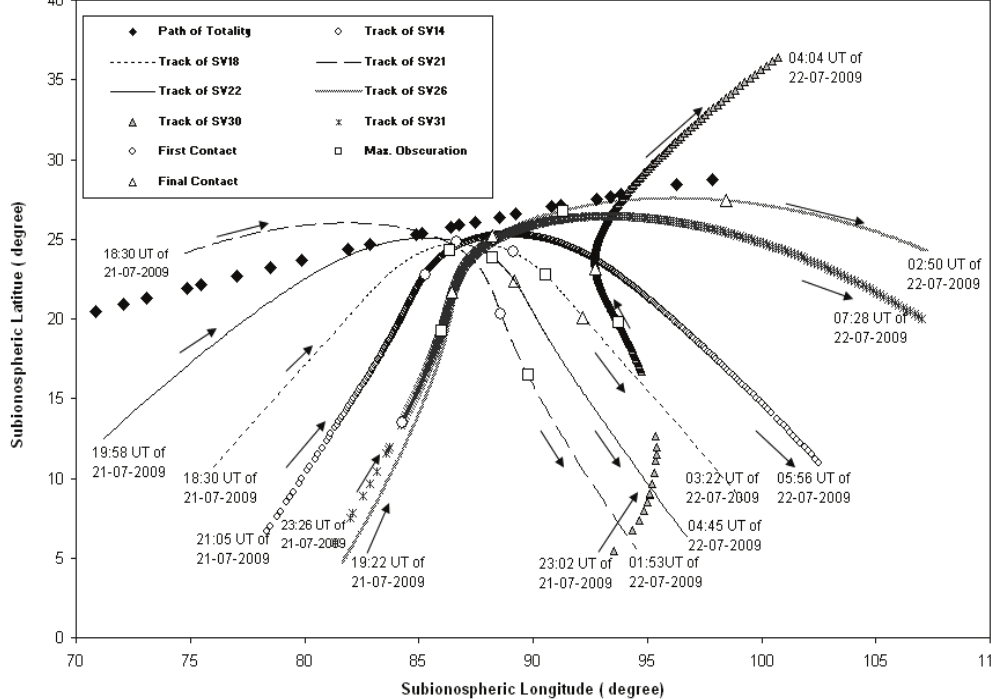
Fig. 4. The tracks of SV14, SV18, SV21, SV22, SV26, SV30 and SV31 during 21–22 July 2009 observed from Kharagpur. The first contact, maximum obscuration and the final contact on each satellite track are shown by circle, square and triangle respectively. The path of totality is also shown in the